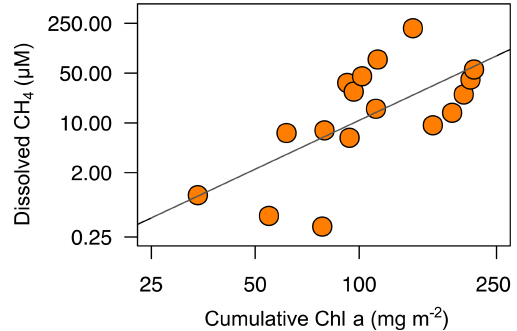
Figure 5. Power relationship between the depth-cumulative chloro- phyll a concentration and the concentration of dissolved CH 4 in the anoxic waters during the stratification period (CH 4 = 3 . 0 × 10 − 4 cumulative Chl a 2 . 28 , n = 17, adjusted R 2 = 0 . 40). Note that both axes are at logarithmic scale. More statistical details can be found in Table